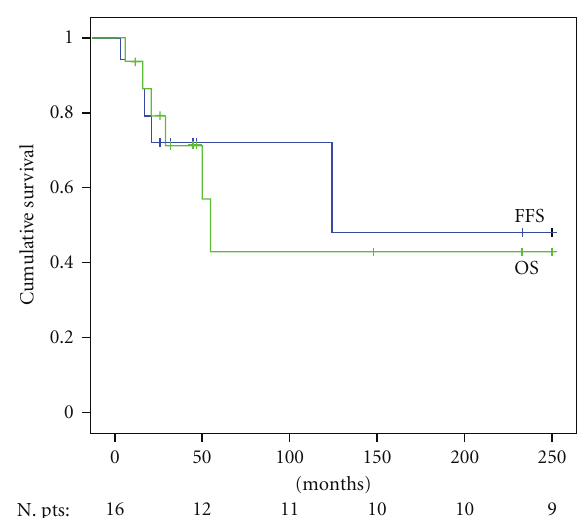
Figure 1: Overall survival and failure-free survival in 16PTS with VLR HL. PTS: patients; VLR: very late relapses; FFS: failure-free survival; OS: overall